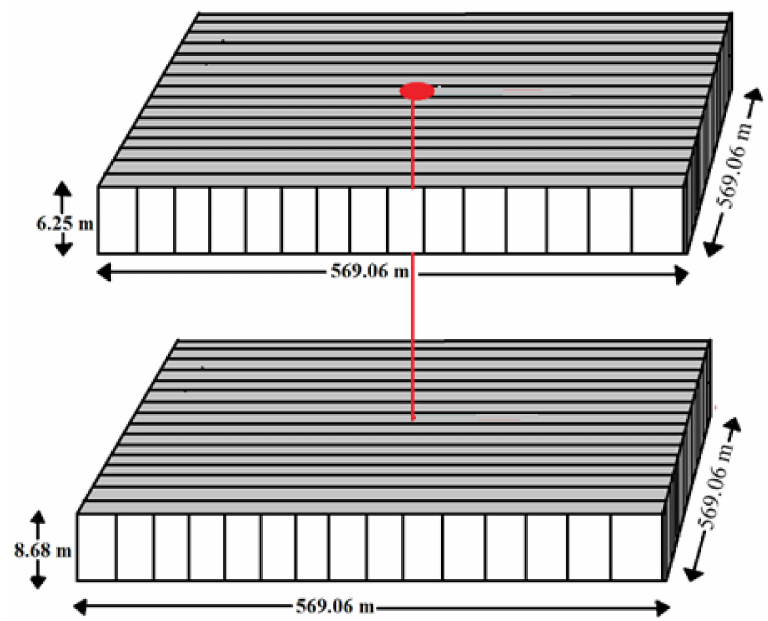
Figure 2. Grid view of block used for reservoir